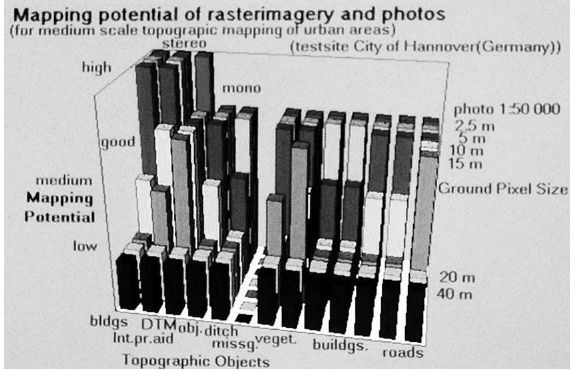
Figure 6. Sample for a 1st research result in 3D photography: The minimum digitization rate for analog 9x9 inch stereo